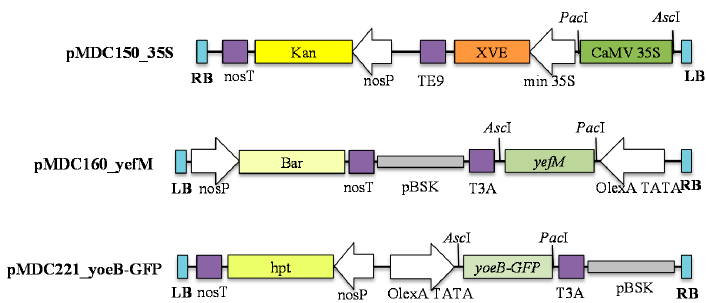
Figure 1. Map of the recombinant constructs used in this study. The T-DNA region of the recombinant activator vector pMDC150_35S and the recombinant responder vectors pMDC160_yefM and pMDC221_yoeBGFP are shown. The left border (LB) and right border (RB) regions flanking the T-DNA are indicated in blue boxes. The transgenes of interest (the cauliflower mosaic virus (CaMV) 35S promoter in pMDC150_35S, yefM Spn in pMDC160_yefM and the yoeB Spn -GFP fusion in pMDC221_yoeB-GFP) were cloned between the Asc I and Pac I unique restriction sites via Gateway recombination. In pMDC150_35S, expression of the XVE activator is driven by the CaMV 35S promoter and is, thus, constitutively expressed. Expression of the transgenes yefM Spn (in pMDC160_yefM) and yoeB Spn -GFP (in pMDC221_yoeB-GFP) are driven by the XVE-responsive promoter (labeled as OlexA TATA ) and are, thus, inducible by 17- β -estradiol [16,17]. The plant selection markers (in yellow boxes and labeled as: Bar, Basta resistance gene; Kan, kanamycin resistance gene; hpt, hygromycin resistance gene) are driven by the nos promoter (labeled as nosP ). TE9, T3A and nosT are transcriptional terminators (indicated in purple boxes); pBSK, pBlueScript backbone (indicated as a grey box).